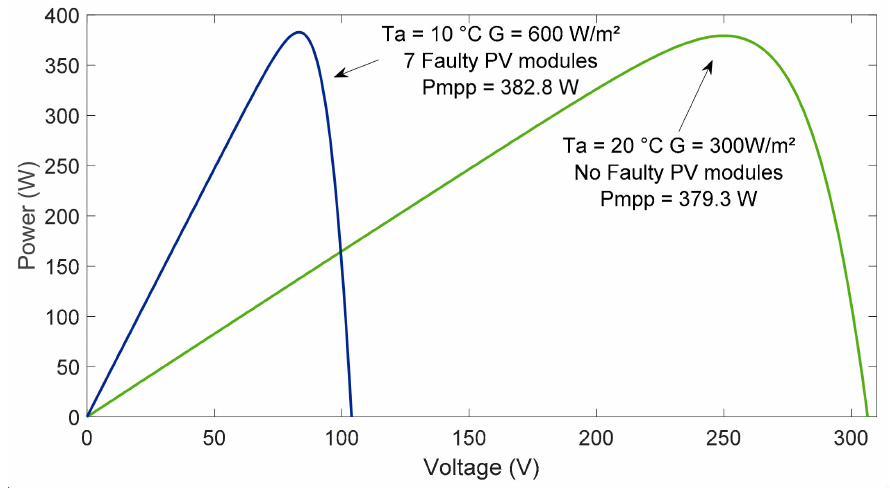
Figure 7. Comparative P–V curves of System 1 between di ff erent faulty situations.